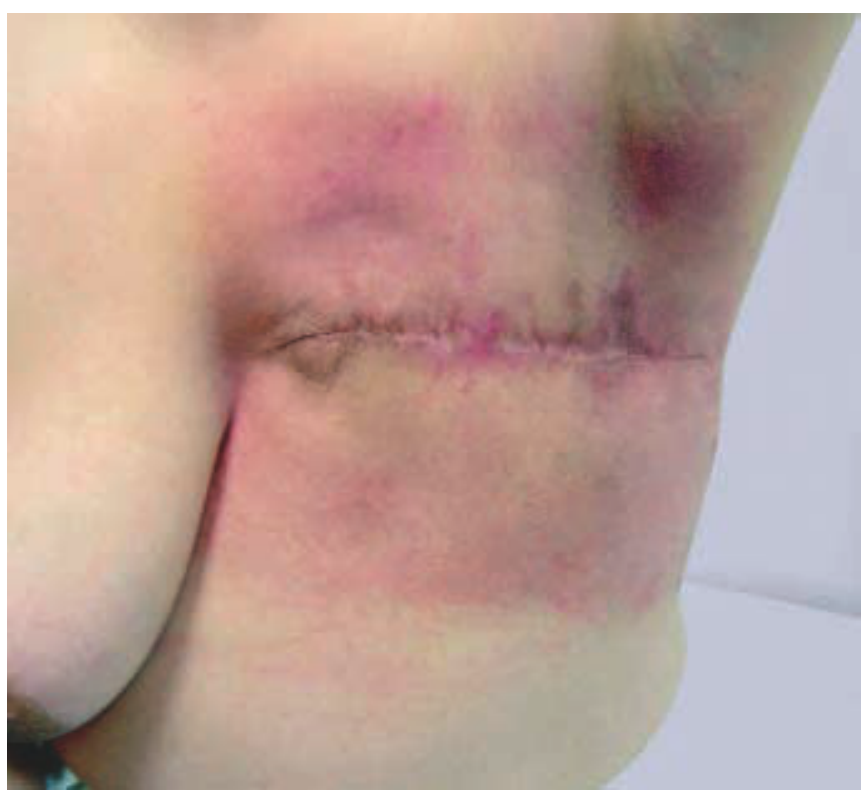
Figure 1 Erythema of the skin in an area corresponding to the previously irradiated